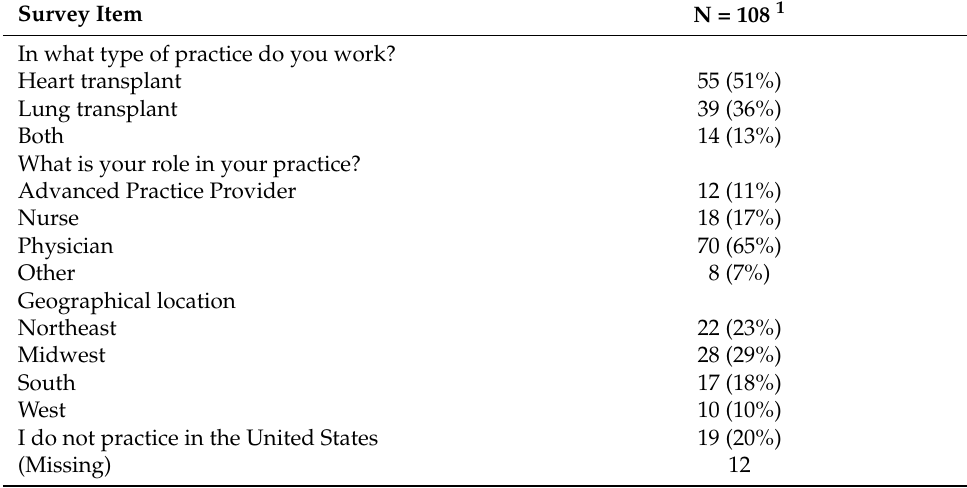
Table 1. Respondent